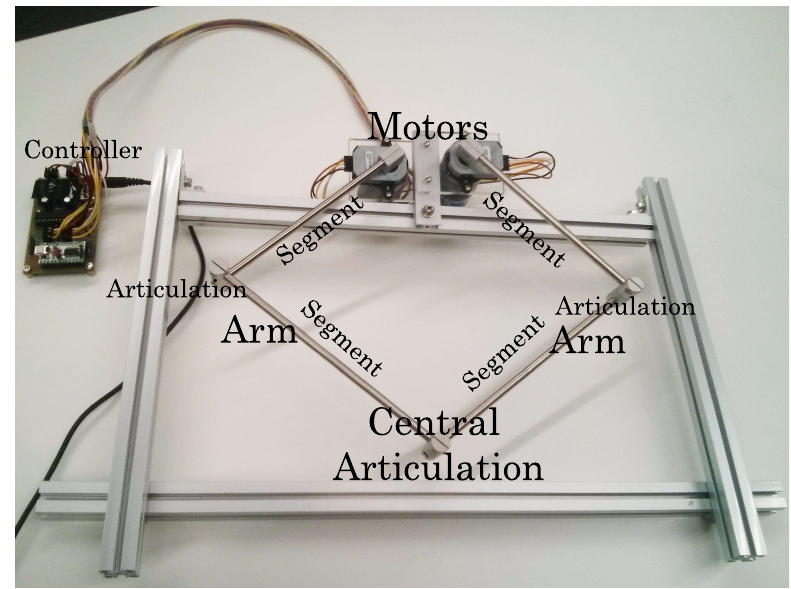
Figure 3. Illustration of the mechanical device.